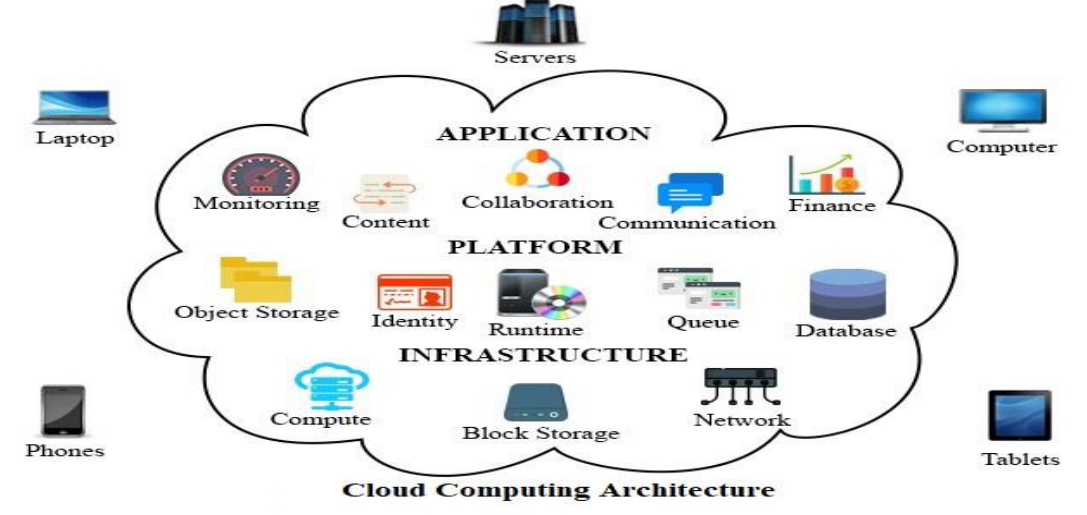
Figure 1 . Architecture of Cloud Computing